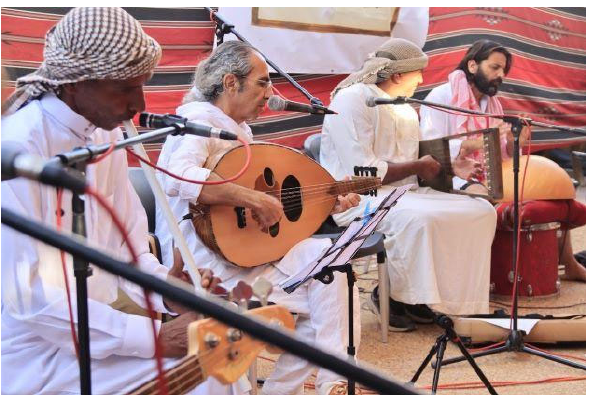
Figure 17. Bedouin music stage show with participation of Israeli musician Yair Dalal, and in col ‐ laboration with the Sharji Jewish ‐ Bedouin Ensemble, at the “Desert Sustainability and Art” Festival, Kuseife, 2021. Photographed by Or Fruchter. Image courtesy of the artist.